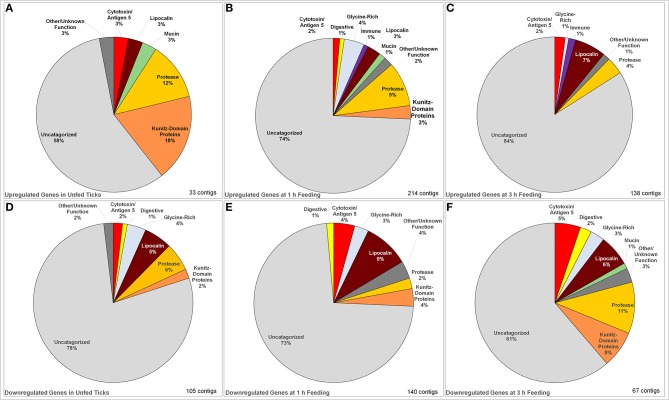
Identified categories of saliva-associated genes in Ixodes ricinus ticks upregulated and downregulated in response to tick infection with TBEV. Upregulation was observed in unfed ticks (A), ticks after 1 h of feeding (B), and ticks after 3 h of feeding (C) showing an overall increase in the number of genes upregulated. The dominant change in upregulation is in uncategorized genes, with the proportion of proteases and serine protease inhibitors decreasing with feeding while upregulation of lipocalins increase. Downregulation was also observed in unfed ticks (D) as well as those at 1 h (E) and 3 h (F) of feeding. In downregulated genes, the proportion of uncharacterized genes decreased while the downregulation of proteases, lipocalins, serine protease inhibitors, and cytotoxins became dominant.